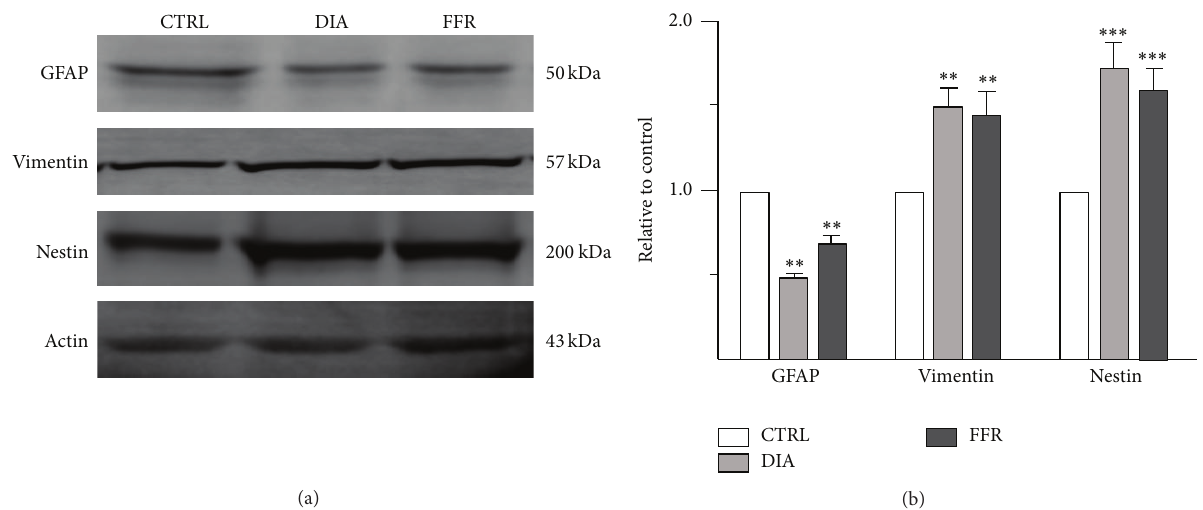
Figure 6: Effect of anorexia on astrocyte intermediate filaments expression after the fifth day. (a) Representative Western blot showing the expression of GFAP, vimentin, and nestin for control, DIA, and FFR experimental groups; actin was used as an internal control. (b) The band intensity of DIA and FFR groups was normalized to their respective controls. Data were shown as mean ± SEM. Significant differences were considered as ∗∗ 𝑝 < 0.01 ; ∗∗∗ 𝑝 < 0.001 .